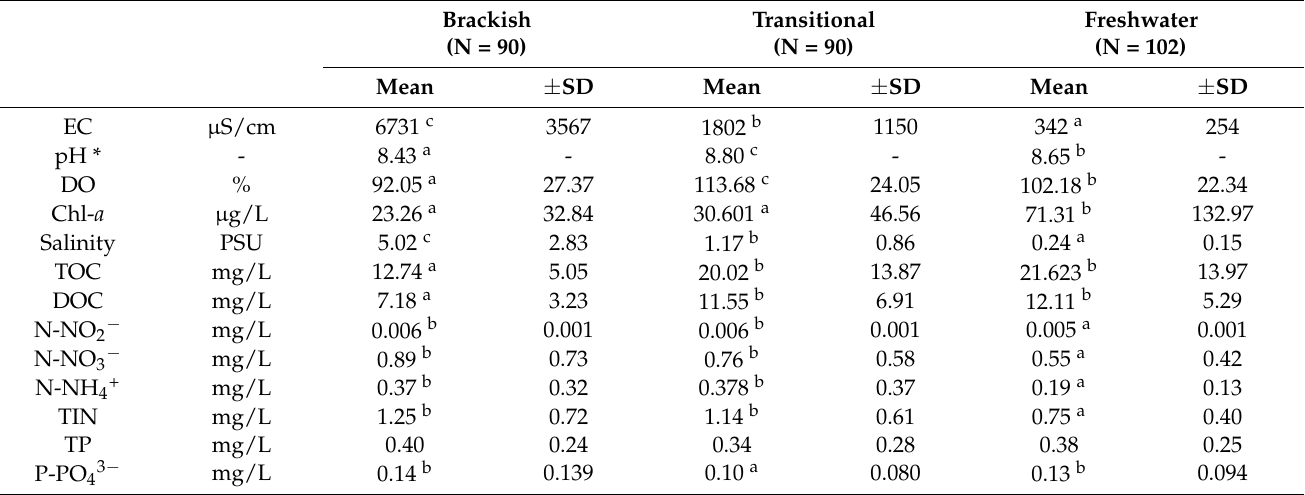
Table 3. Mean values ( ± SD—standard deviation) of physico-chemical parameters of water. Statistically significant differences between groups of lakes are depicted with superscripts ( a , b , c ); (One-way ANOVA, Tukey’s HSD test as a post hoc procedure, p < 0.05). Denotations: DO = dissolved oxygen; TOC = total organic carbon; DOC = dissolved organic carbon; EC = conductivity; TIN = total inorganic nitrogen, TP = total phosphorus. N—number of samples analysed; *—median. Brackish